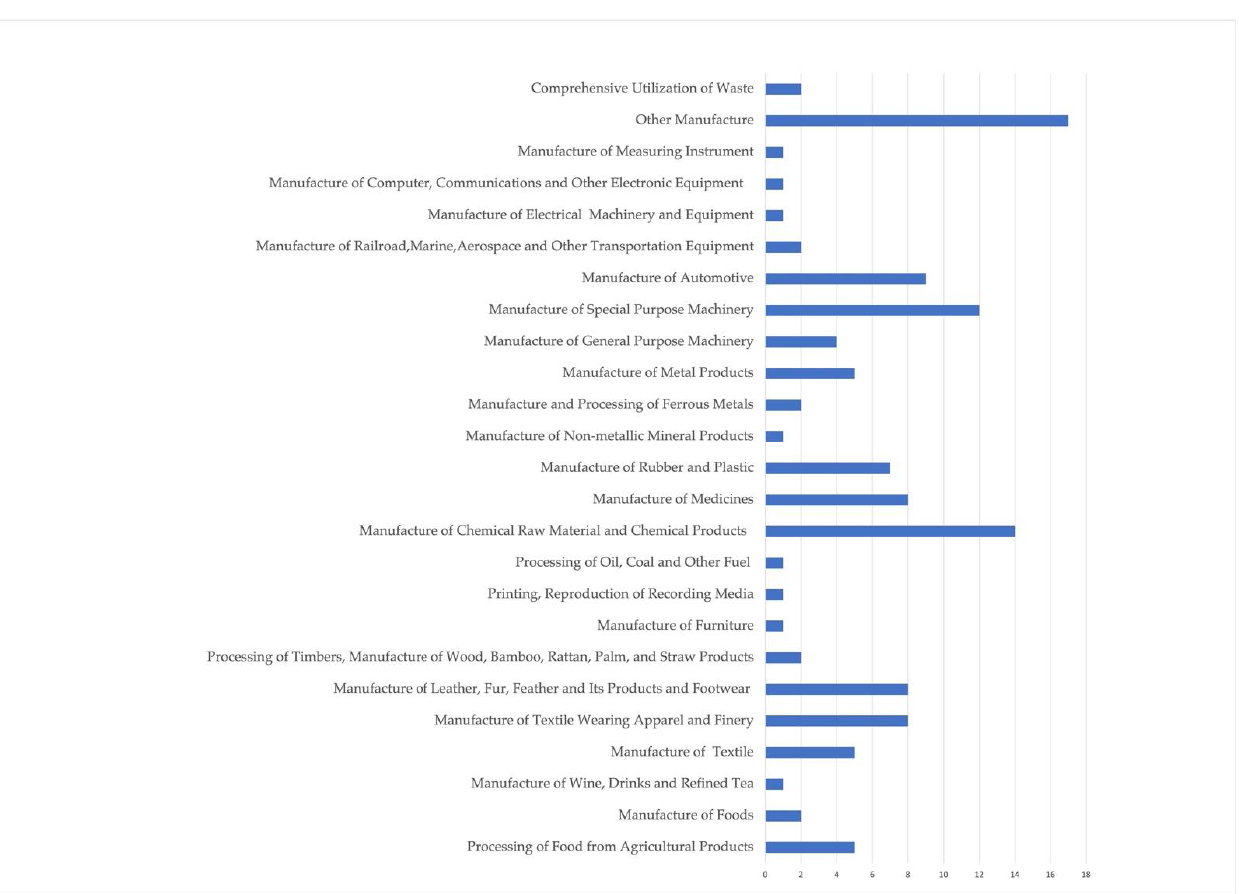
Figure 3. Composition of firms’ industry categories in the valid questionnaires.